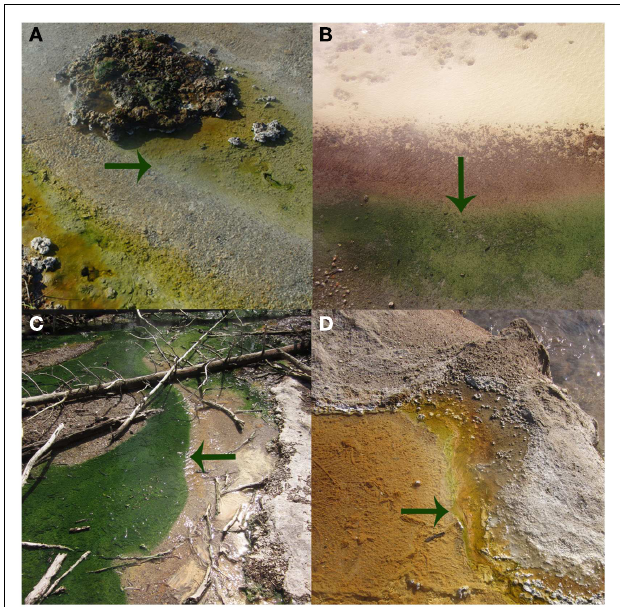
FIGURE 3 |The photosynthetic fringe, or the transition from chemosynthetic to photosynthetic metabolism, as denoted by arrows, for Bijah Spring in March 2010 (A), Dragon Spring in March 2010 (B), Nymph Creek in March 2010 (C), and Perpetual Spouter inAugust of 2011 (D).